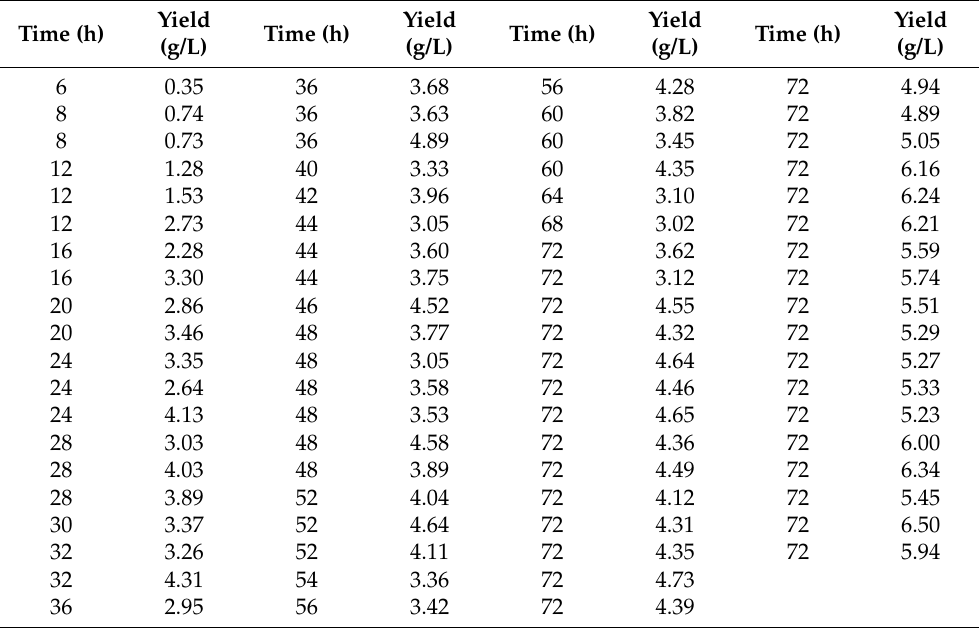
Table 1. Gellan gum yield of S. paucimobilis ATCC 31461 and its mutant strains at different fermenta- tion time determined by physical and chemical